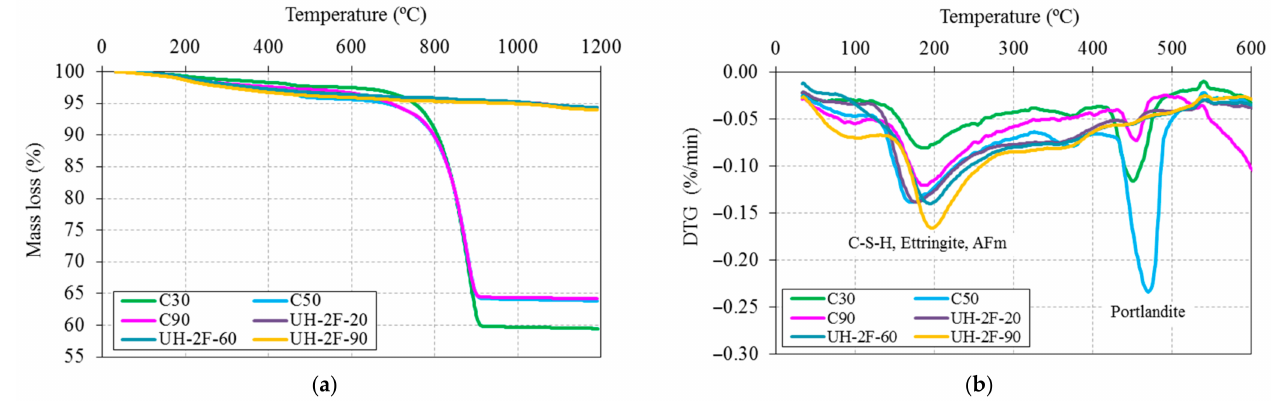
Figure 10. ( a ) TG; and ( b ) DTG curves of concretes.